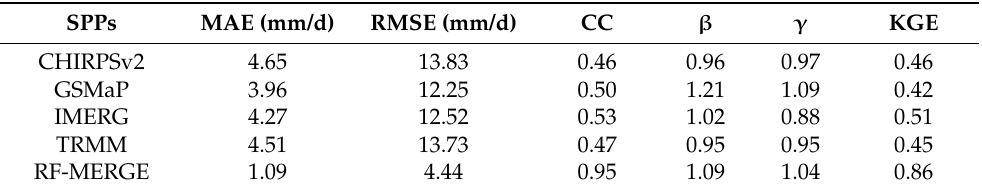
Table 3. Error statistics for four precipitation products and the RF merging product at daily scale from 2003 to